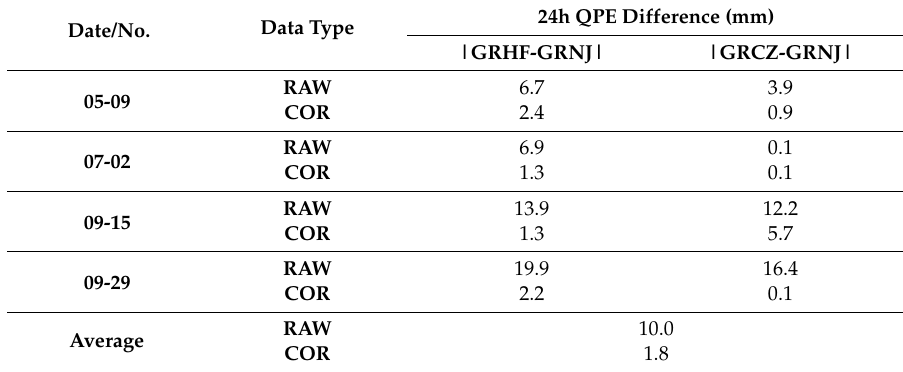
Figure 10. Raw and corrected QPE profile along the A-B-C-D-E line of Figure 9a. B is the midpoint of GRHF and GRNJ, D is the midpoint of GRNJ and GRCZ. Blue arrows indicate spatial discontinuity. ( a )–( d ) indicate 05-09, 07-02, 09-15 and 09-29 precipitation events, respectively. Table 2. Differences of 24h accumulated QPE in overlapping areas of adjacent GRs. Date/No. Data